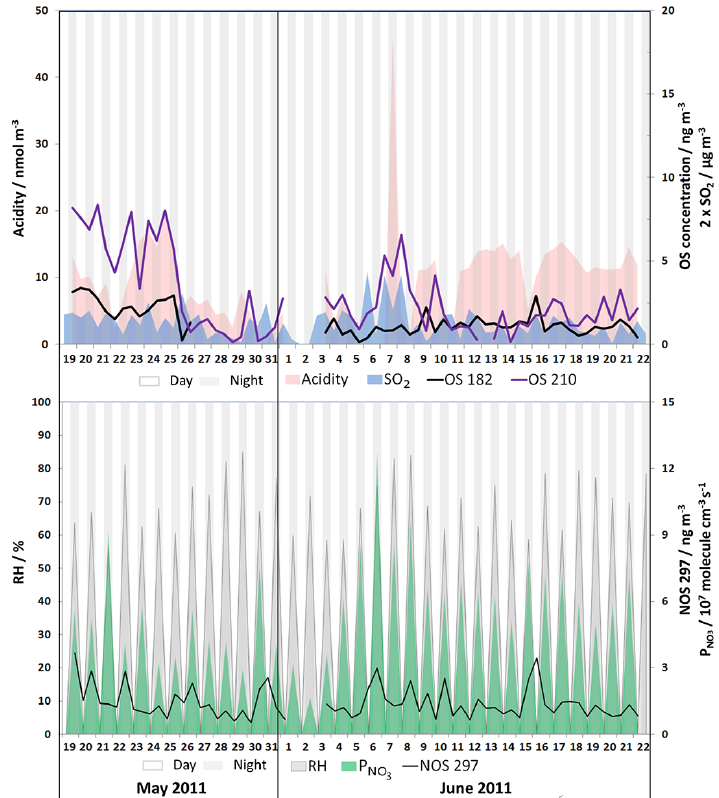
Figure 5. Time profiles of selected species of significantly higher concentration levels at HCAB, including OS 182, OS 210 and NOS 297. Concentrations of OS 182 and OS 210 are shown against level of SO 2 and acidity at HCAB, while concentration trend of NOS 297 is shown against nighttime production rate of NO 3 radical and nighttime relative humidity at